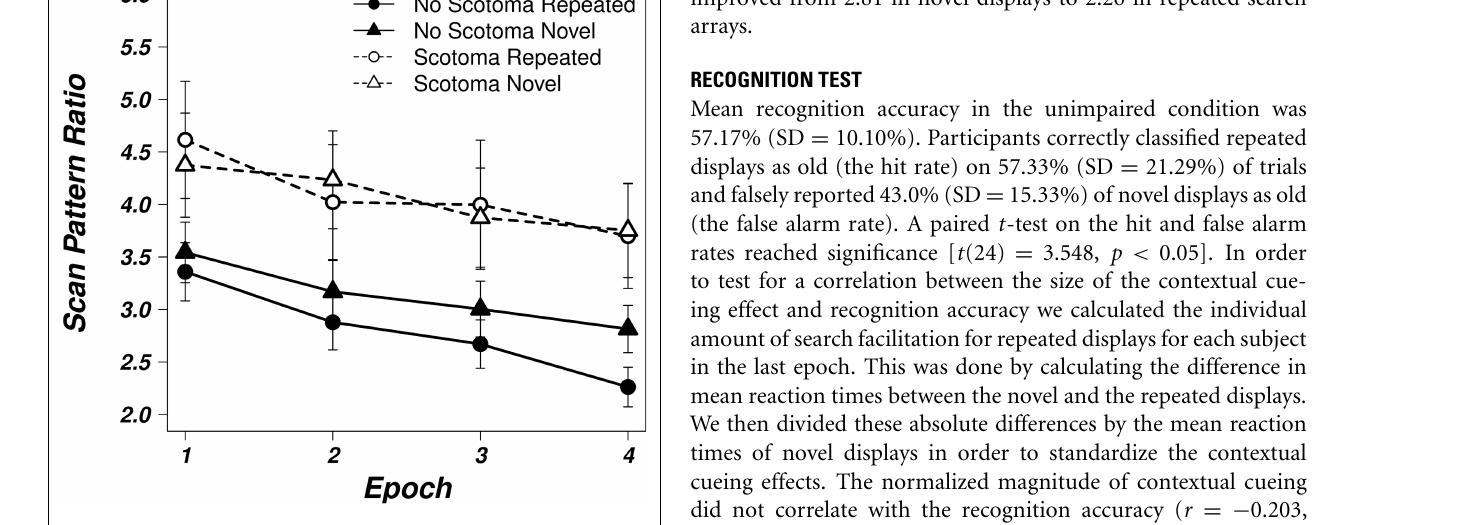
FIGURE 4 |Averaged scan pattern ratios for the unimpaired (solid, filled symbols) and scotoma (dashed, open symbols) viewing conditions for repeated (circles) and novel (triangles) displays as a function of epoch. Error bars represent the standard error of the mean.